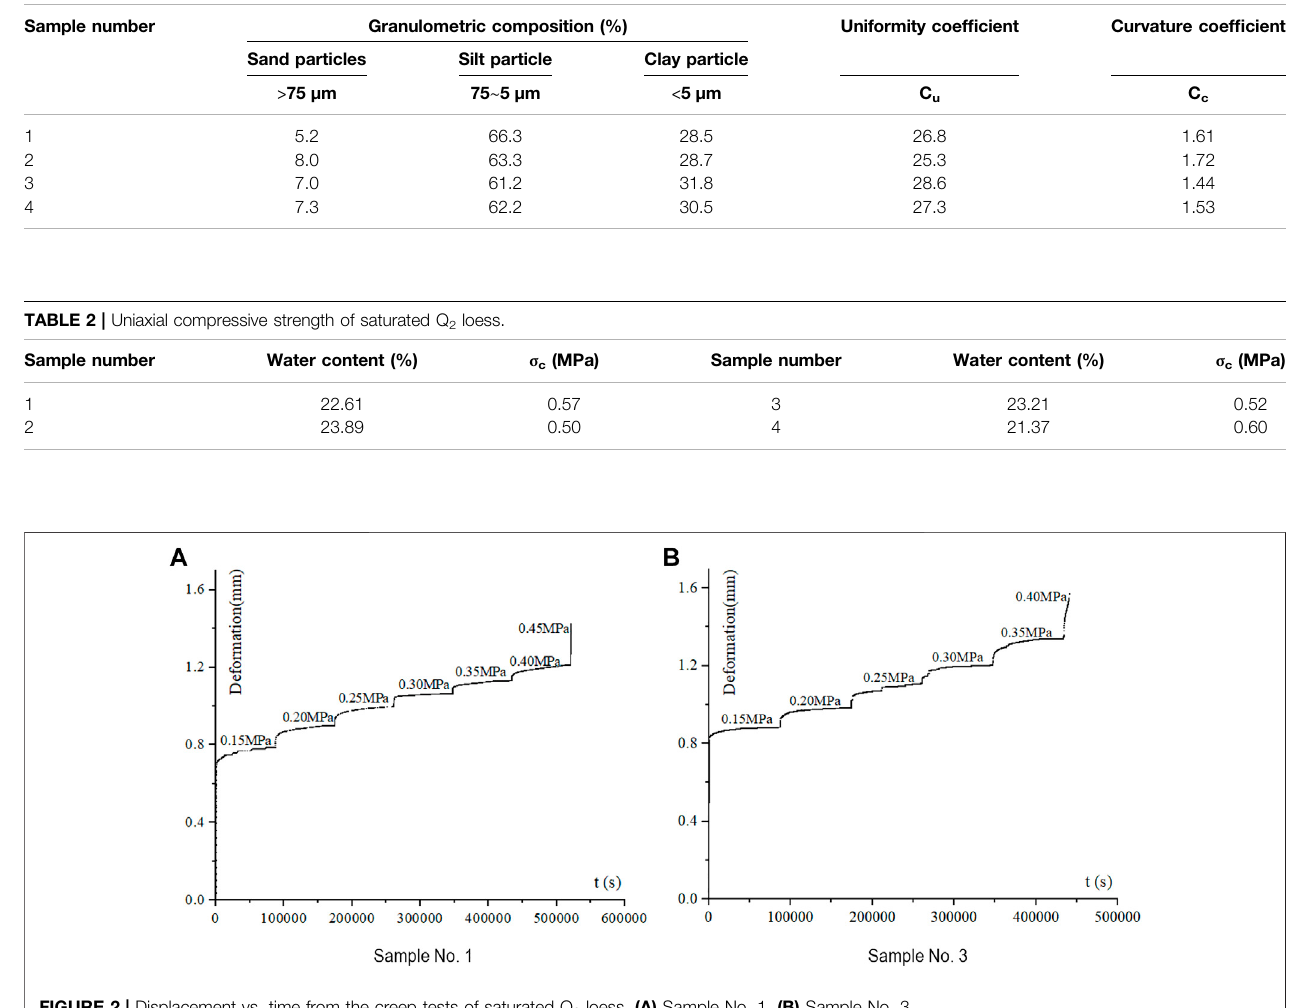
Frontiers in Earth Science |